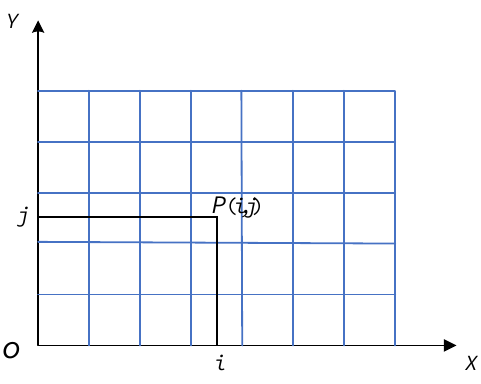
Figure 1. Operating pathway coordinate system.